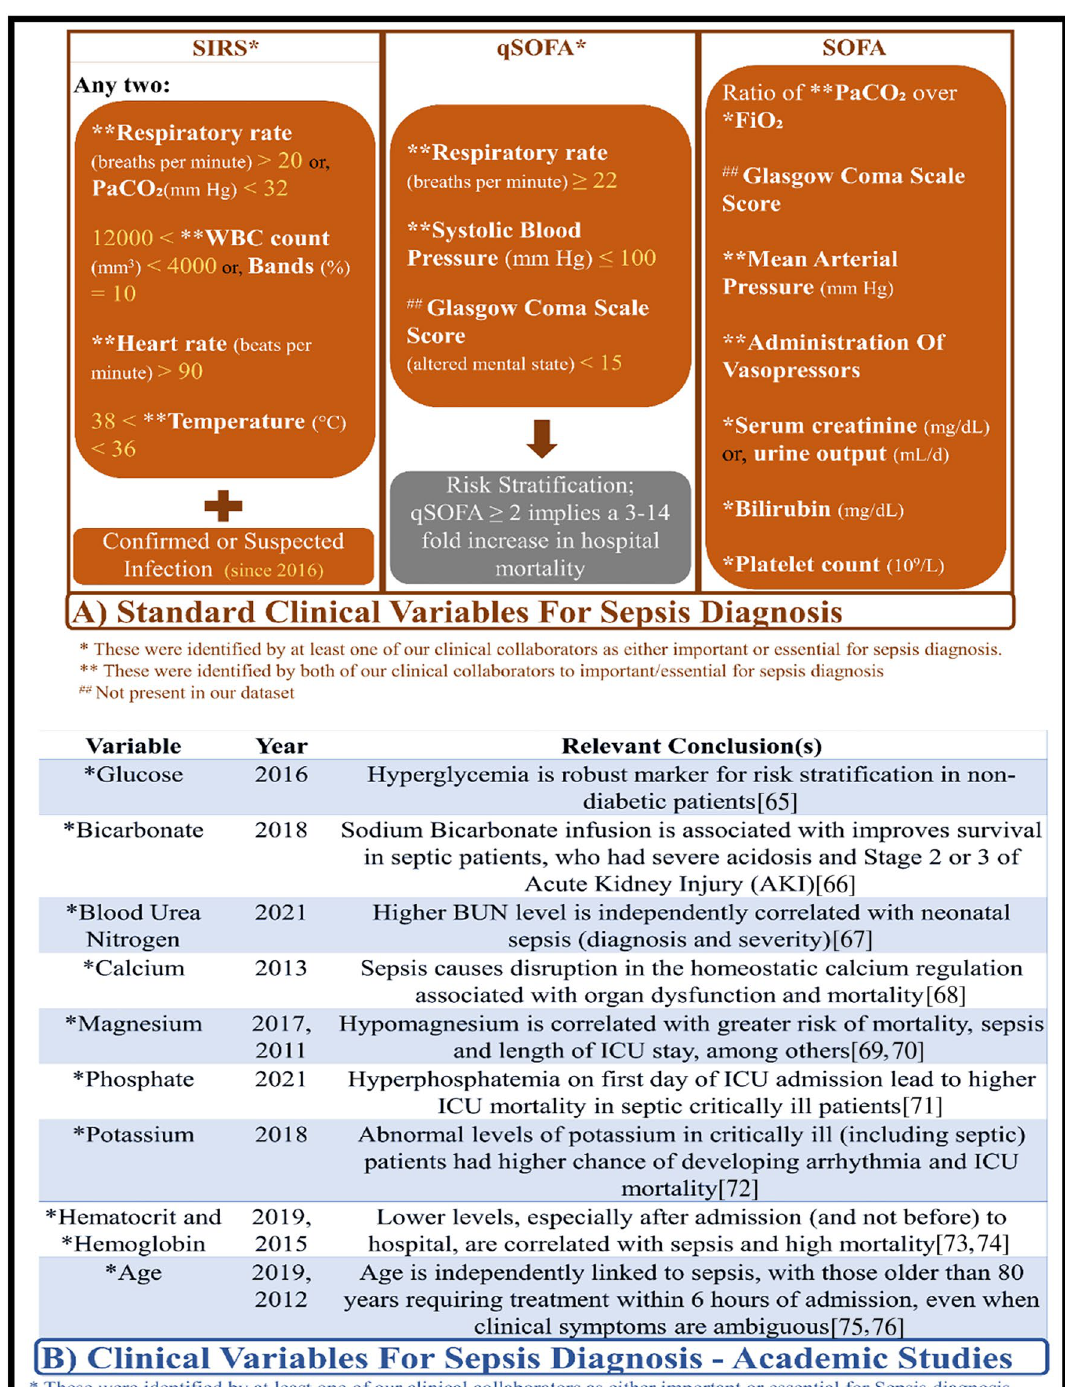
Figure 1. This figure shows the different clinical variables that are known to be affected by sepsis or septic shock. ( A ) Shows the clinical variables used in practice by clinicians to diagnose sepsis. ( B ) Shows the clinical variables that are independently correlated with sepsis and/or those variables specific to certain type of cohort. The “Year” column refers to the year the cited papers were published. The clinical diagnosis scoring ranges are: Systemic Inflammatory Response Syndrome (SIRS) Criteria: (Range, 0–4 Criteria); Quick Sequential [Sepsis- related] Organ Failure Assessment: (qSOFA) (Range, 0–3 Points); Sequential [Sepsis-related] Organ Failure Assessment (SOFA): (Range, 0–24